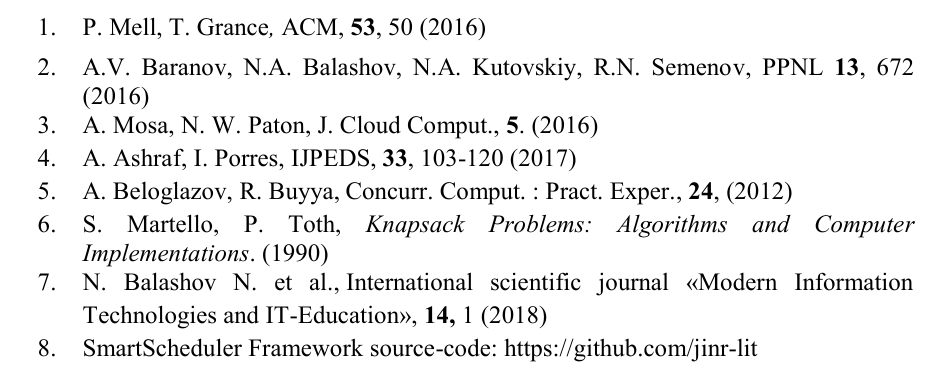
Fig. 4. Main components of the software